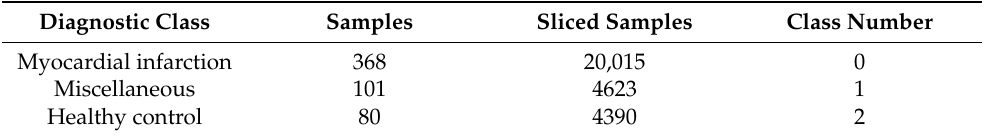
Table 2. Number of electrocardiograms samples, number of sliced electrocardiograms and class number for the three